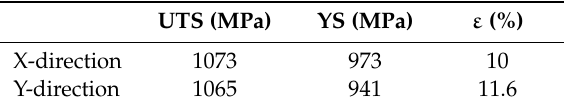
Table 5. Comparison between the tensile properties of DED Ti-6Al-4V in different directions [33].